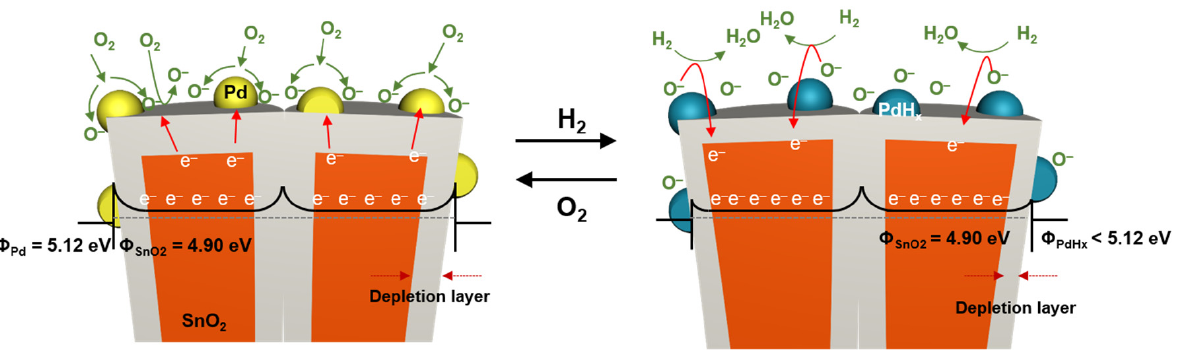
Figure 2. Schematic image of the sensing reaction mechanism of Pd-coated SnO 2 NR arrays in air and hydrogen.